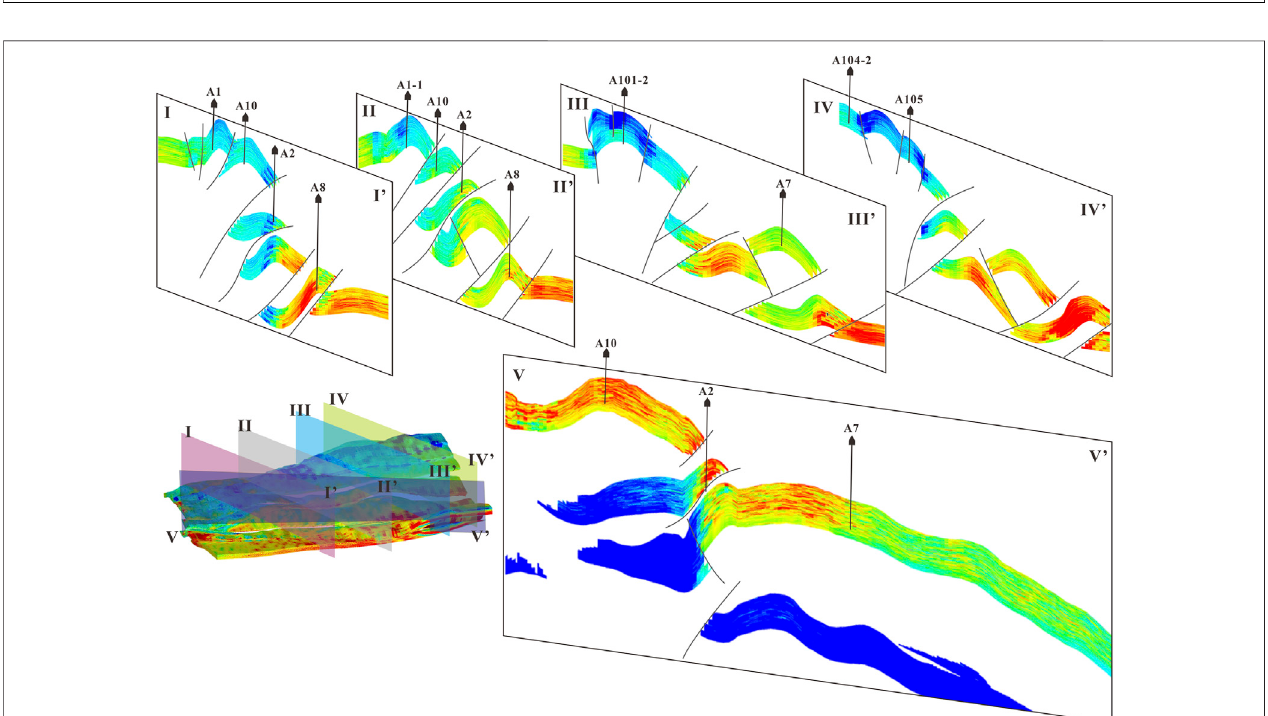
FIGURE 6 | In situ stress distribution in a typical section of the Bozi gas fi eld.